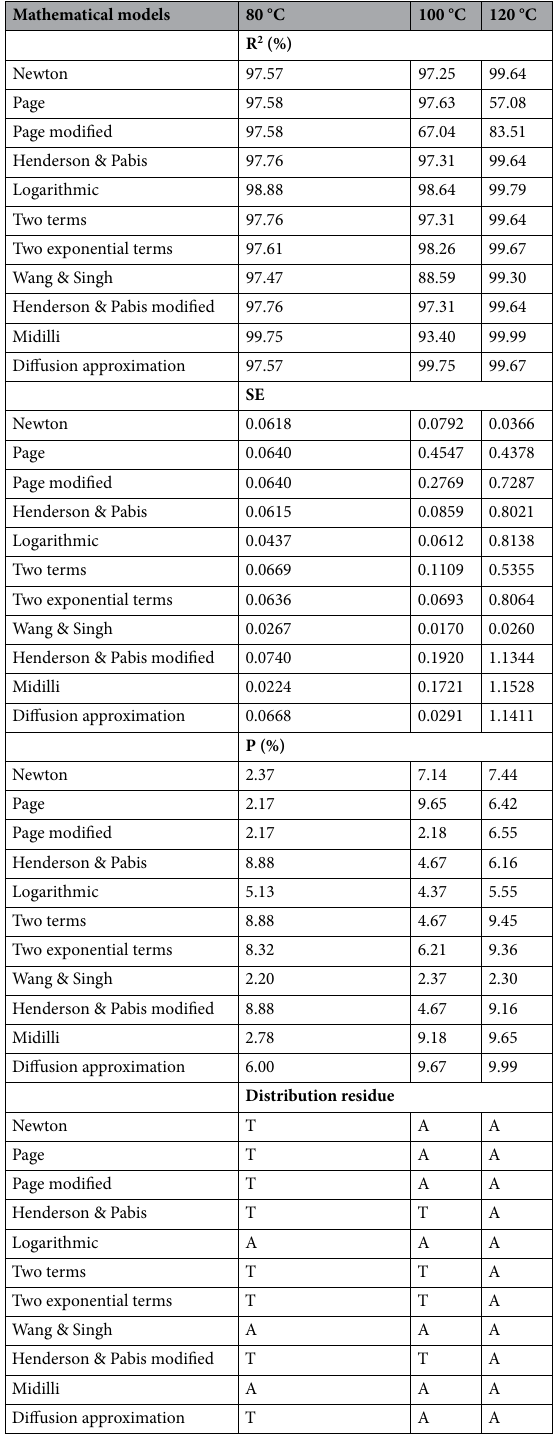
Table 4. Coefficient of determination (R 2 ), mean relative error (P), estimated values of average error (SE) drying of soybean grains due to different temperatures for 18% (d.b.) of initial moisture